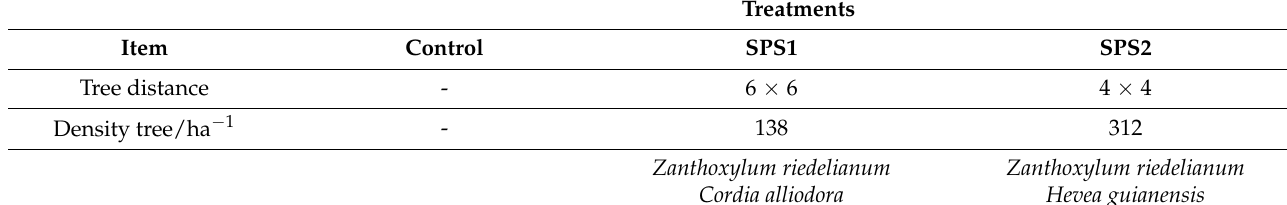
Table 4. Predominant species of trees found in silvopastoral systems evaluated with guinea grass.